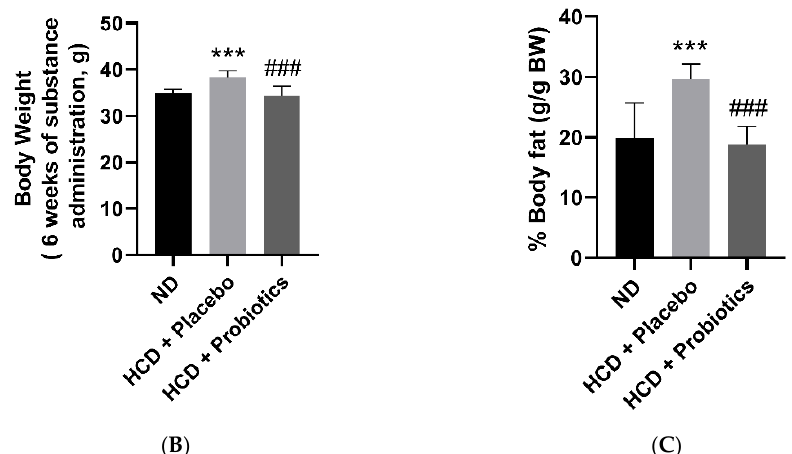
Figure 2. Effect of MSPs on obesity in HCD-fed mice. ( A ) Mouse body weight over the course of 18 weeks. ( B ) Effect of MSPs on body weight after 6 weeks of administration. ( C ) Effect of MSPs on body fat percentage after 6 weeks of administration. Data are expressed as mean ± standard deviation ( n = 5 per group). *** p < 0.001 vs. ND; ### p < 0.001 vs. HCD + placebo. Legend: HCD, high-carbohydrate diet; MSPs, multi-strain probiotics; ND, normal diet.